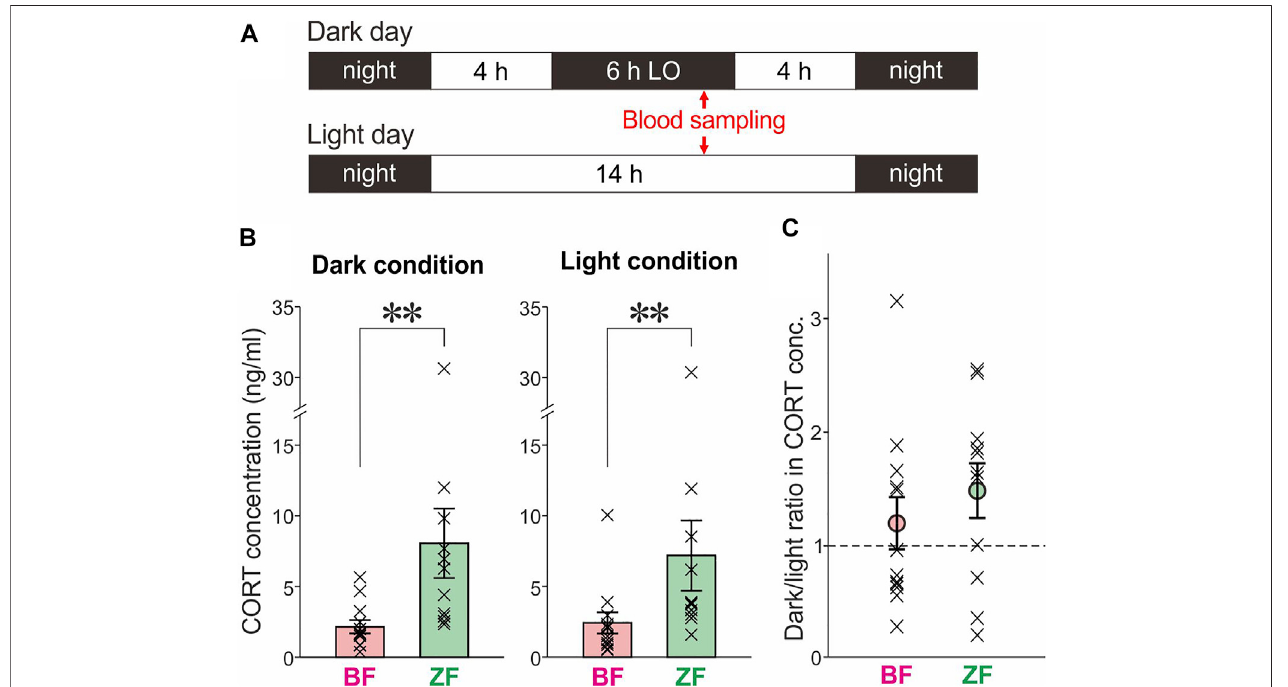
FIGURE 4 | Comparison of blood CORT levels in dark and light conditions between BFs and ZFs. (A) Daily schedules of blood sampling with and without LO. (B) Blood CORT levels in BFs and ZFs under dark (left) and light (right) conditions. BFs showed signi fi cantly lower CORT levels than ZFs in both conditions (** p < 0.01). (C) Dark/lightratiosinCORTlevelswerenotsigni fi cantlydifferentfrom1eitherinBFs( p =0.73)orinZFs( p =0.32).Nosigni fi cantdifferencewasfoundbetweenBFsandZFs ( p = 0.28).